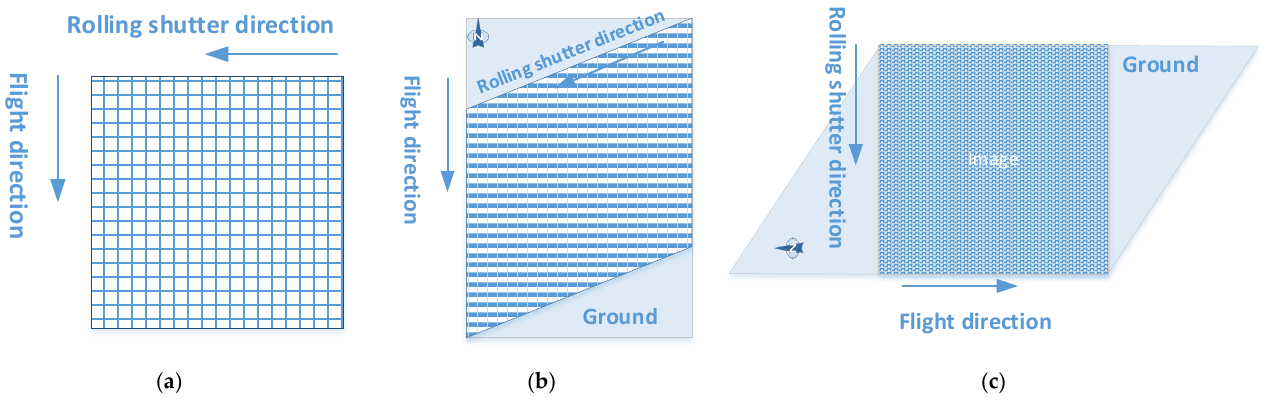
Figure 1. The schematic diagram of CMOS sensor imaging with rolling shutter perpendicular to the motion direction. ( a ) Imaging design of CMOS sensor with rolling shutter; ( b ) ground coverage corresponding to a frame of CMOS image by rolling shutter; ( c ) The output CMOS image by rolling shutter.